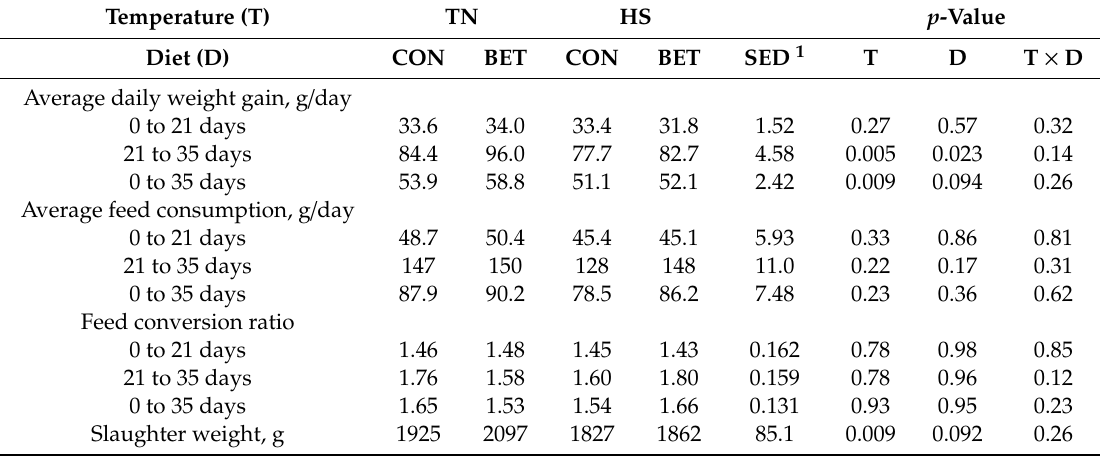
Table 1. E ff ect of betaine (BET) on average daily weight gain, average daily feed consumption and feed conversion ratio and final slaughter weight during thermoneutral (TN) and heat stress (HS)